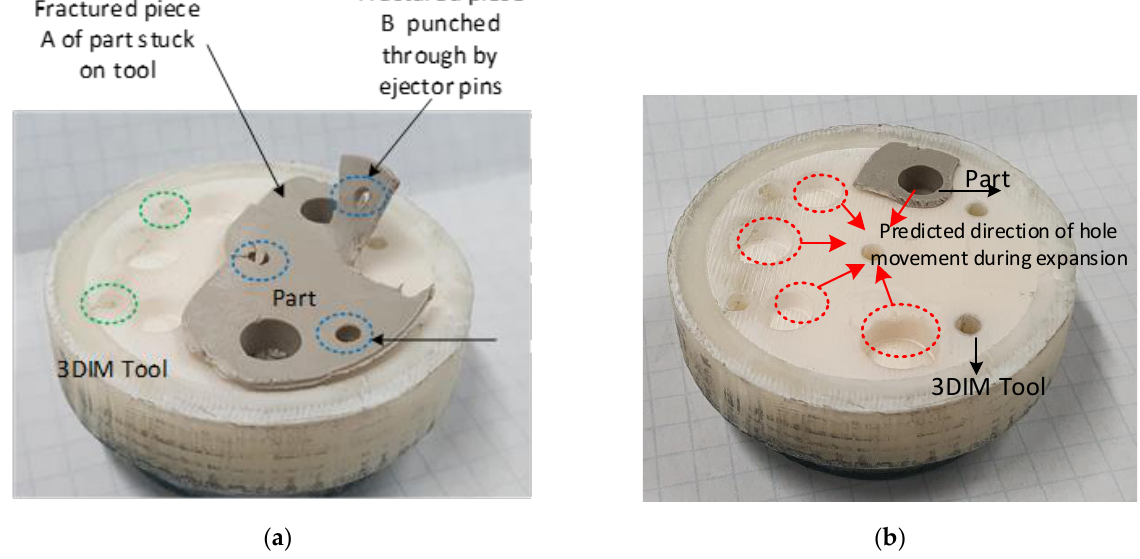
Figure 17. ( a ) Broken part with punched ejector holes stuck inside 3DIM cavity; ( b ) 3DIM cavity with broken part stuck inside after ejection and highlighting the potential expanded state of the cavity holes in a red circle.